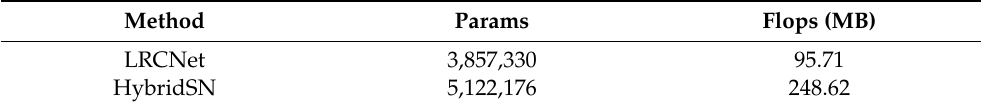
Table 4. The comparison of the number of parameters and computational